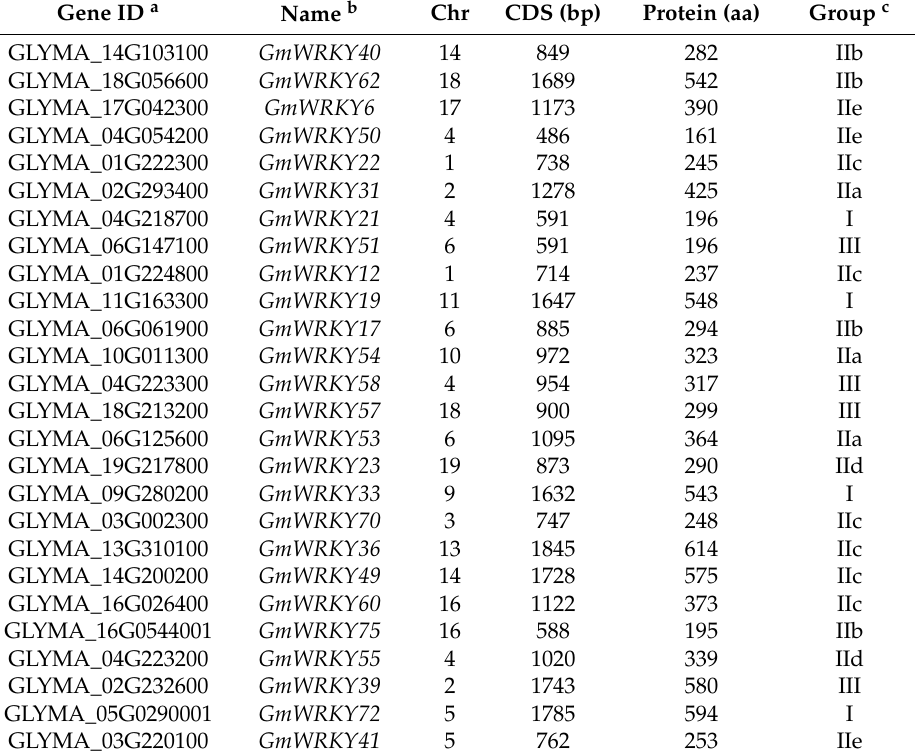
Table 1. Annotation of Glycine max WRKY transcription factors responding to drought stress